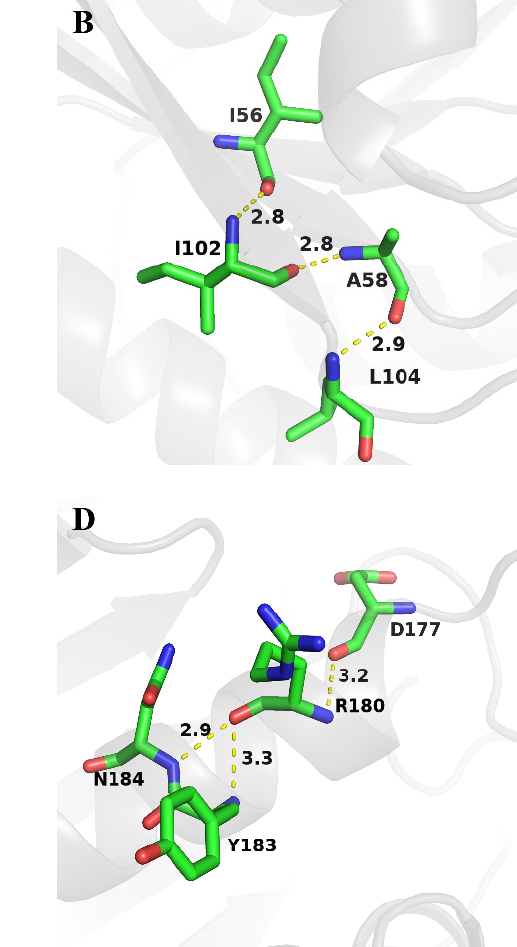
Change in the residue interactions around the 180th residue. in the residue interactions around the 180th